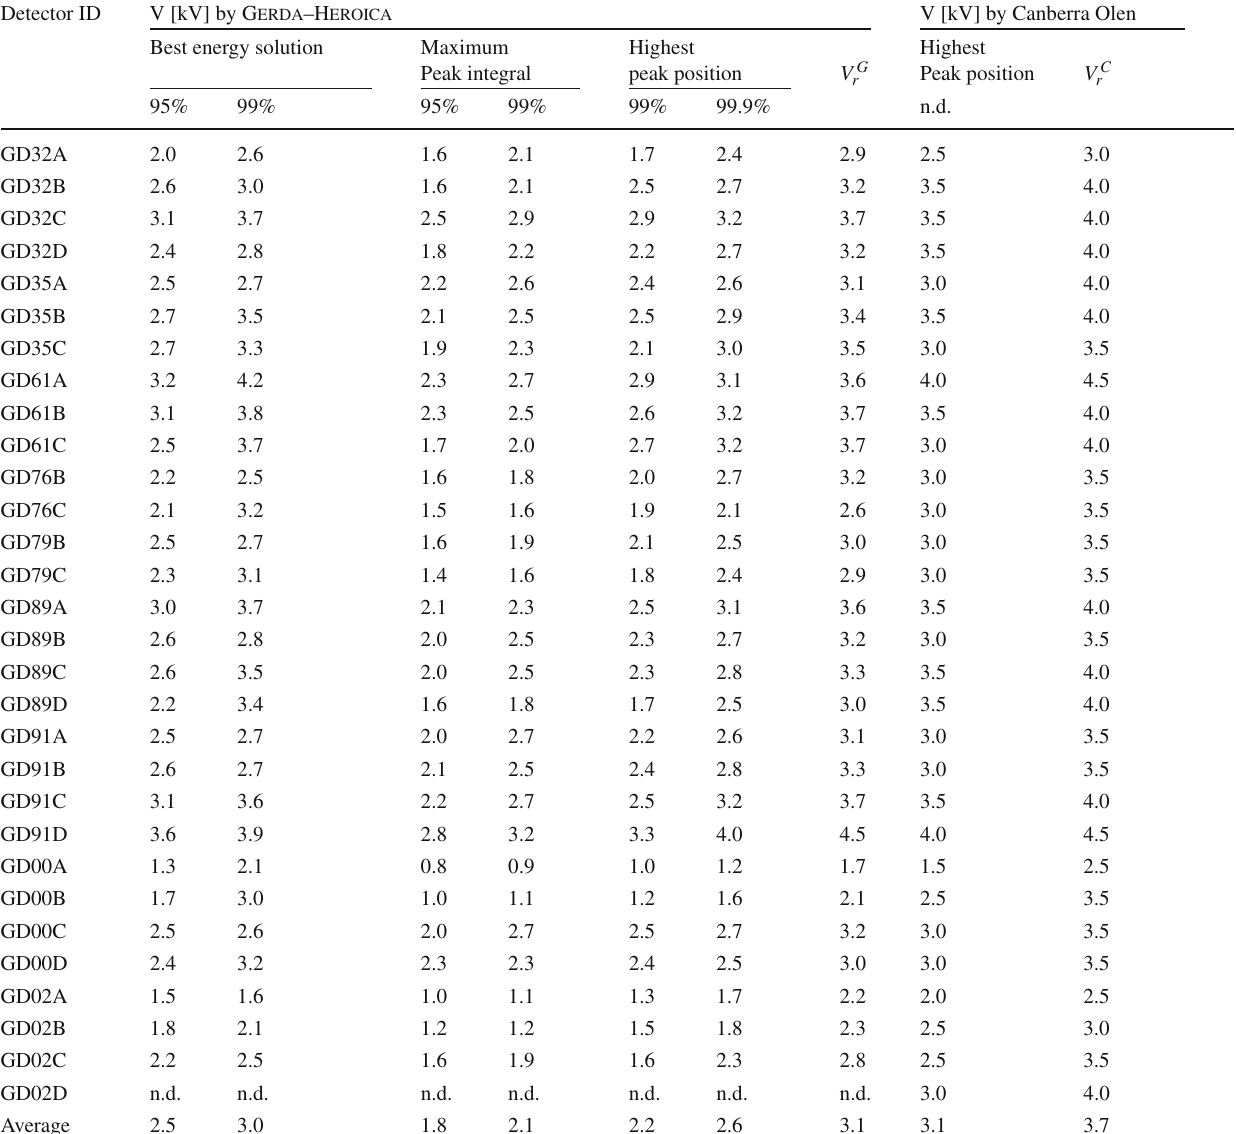
new operational voltages proposed for the usage in Gerda Phase II are denoted with V G r . The full depletion and recommended voltages V C r , which were deduced from a peak position curve by Canberra Olen, are reported in the last two columns. No data is abbreviated with